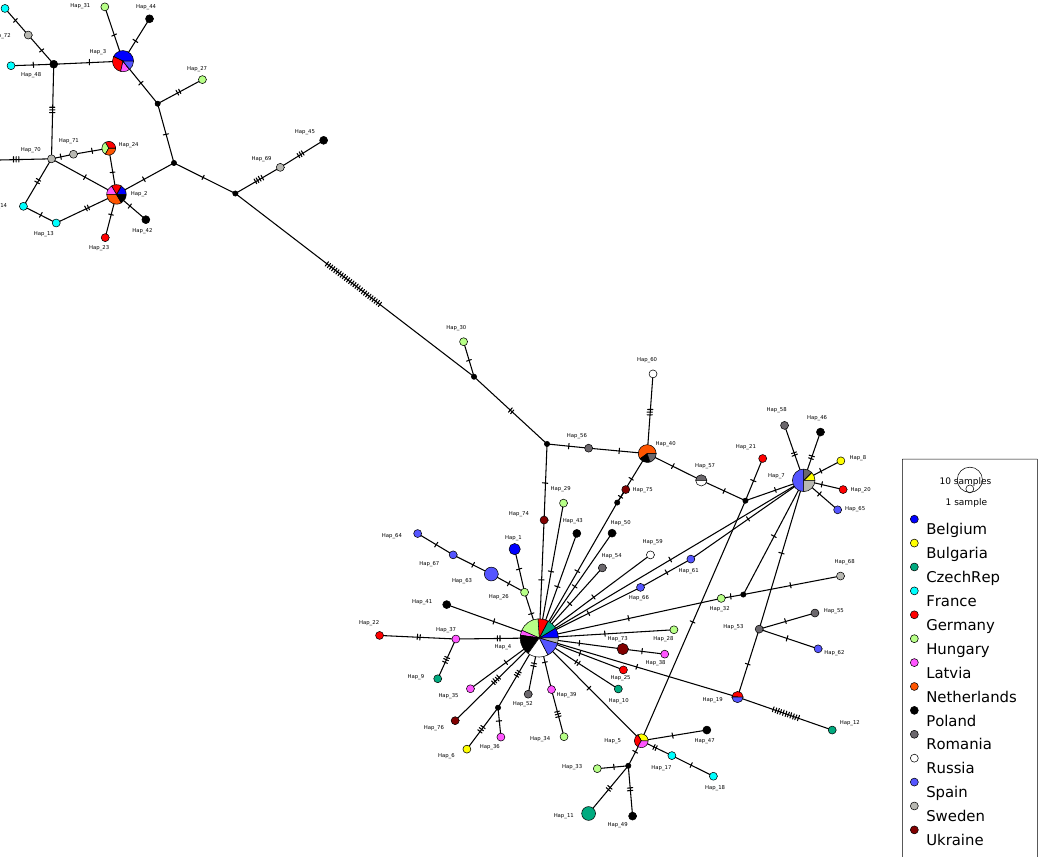
Figure 1. Minimum-spanning haplotype network based on the concatenated Cytb and CO1 genes. Circle size reflects frequency of the haplotypes. The small black circles indicate missing node haplotypes. Each small vertical line traversing the connecting line between two haplotypes corresponds to one mutation